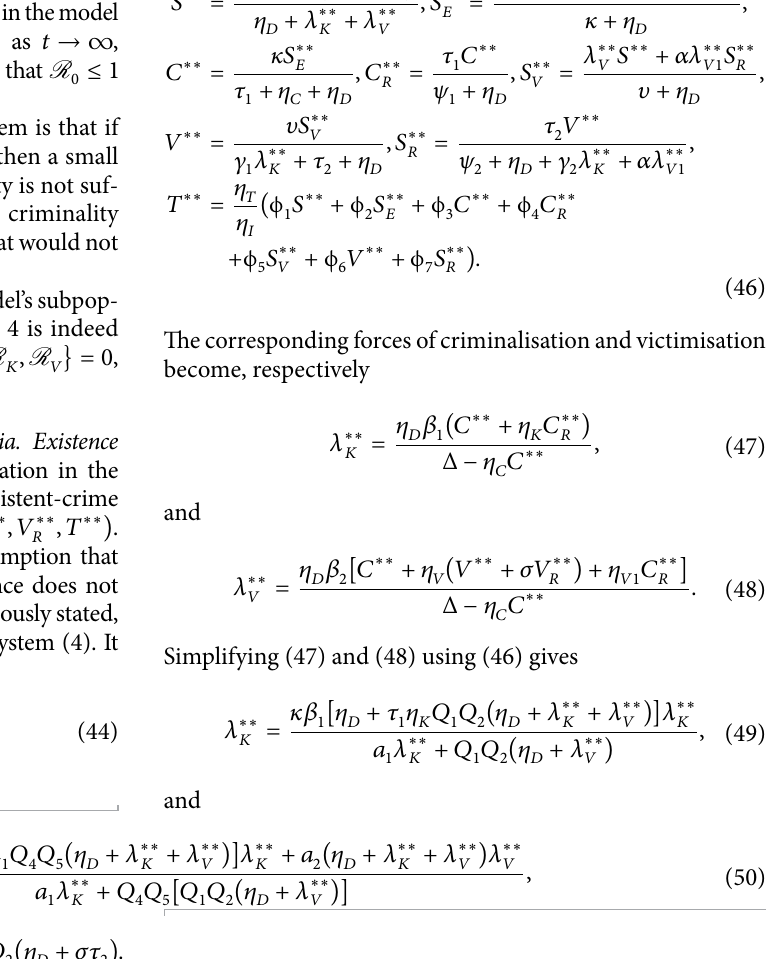
, is GAS when R 0